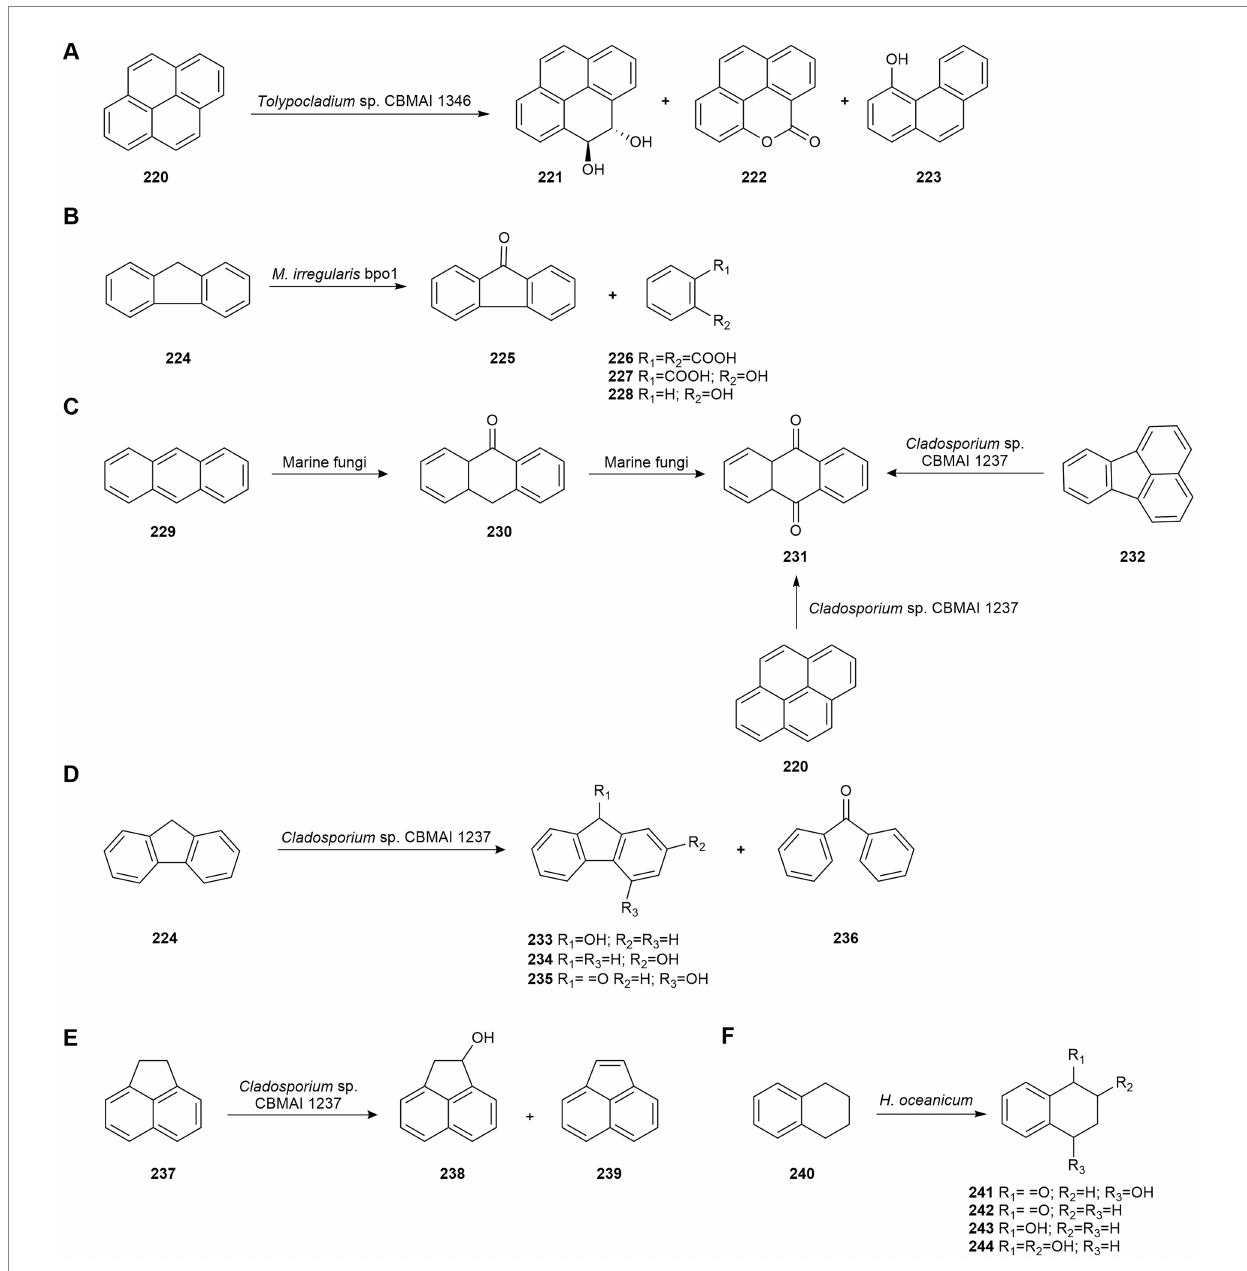
FIGURE 11 Biodegradations of petroleum hydrocarbons. (A) Pyrene ( 220 ) biodegradation by Tolypocladium sp. CBMAI 1346 (Vasconcelos et al., 2019). (B) Fluorene ( 224 ) biodegradation by Mucor irregularis bpo1 (Bankole et al., 2021b). (C) Biodegradation of anthracene ( 229 ), anthrone ( 230 ), pyrene ( 220 ), and fluoranthene ( 232 ) by Cladosporium sp. CBMAI 1237 (Birolli et al., 2018a). (D) Fluorene ( 224 ) biodegradation by Cladosporium sp. CBMAI 1237 (Birolli et al., 2018a). (E) Acenaphthene ( 237 ) biodegradation by Cladosporium sp. CBMAI 1237 (Birolli et al.,